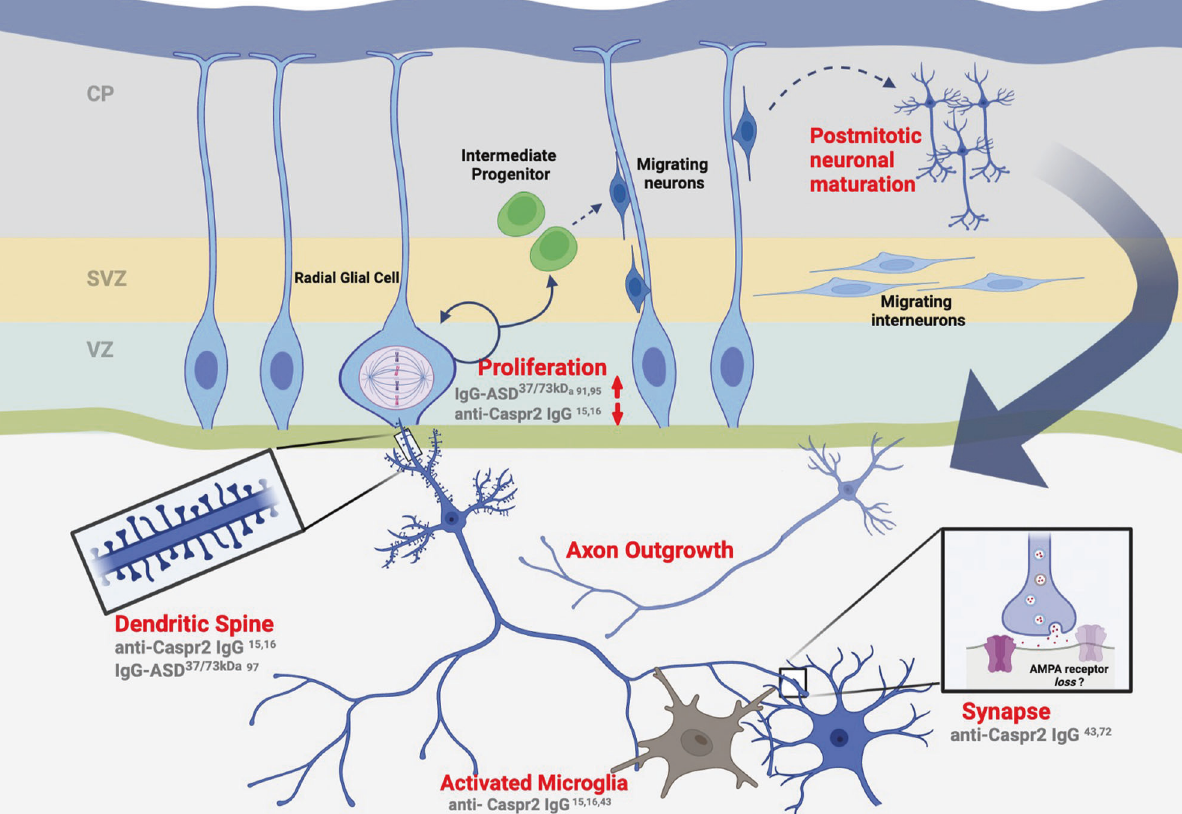
Fig. 1 Summary of the abnormalities in the embryonic and postnatal mouse brain altered by brain-reactive Abs of mothers of a child with ASD. Abs are listed in gray. Figure was created with